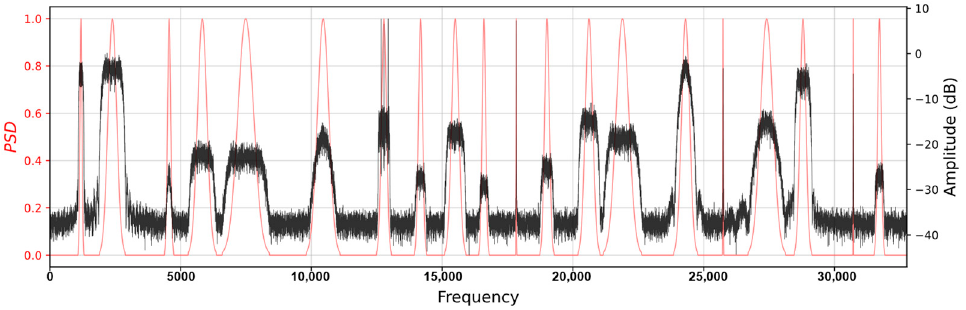
Figure 4. The PSD target example of the input power spectrum.